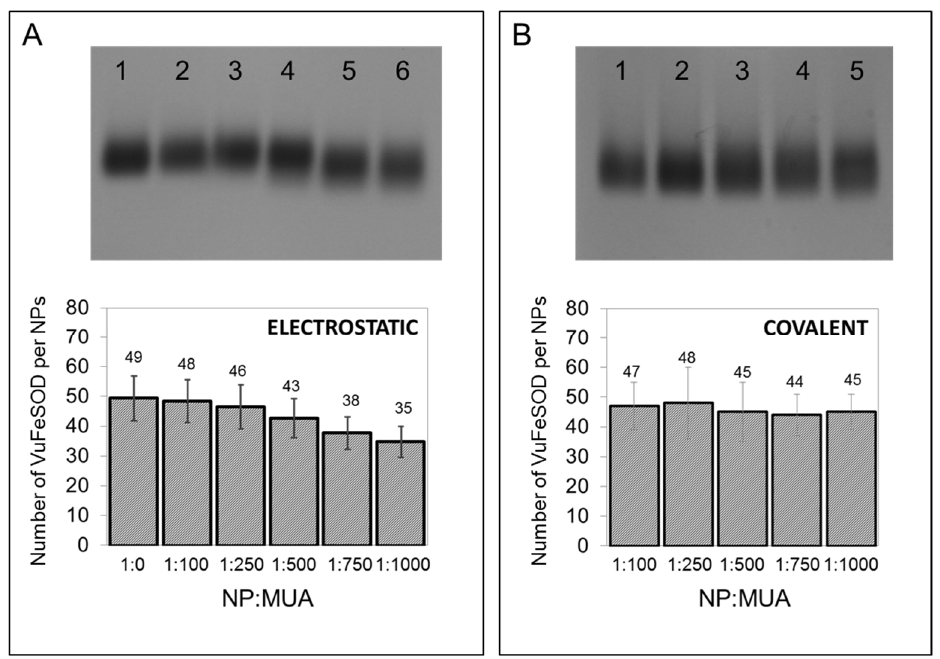
Figure 5. 3D model for a monomer of Vu FeSOD: Lysine residues are presented in red.